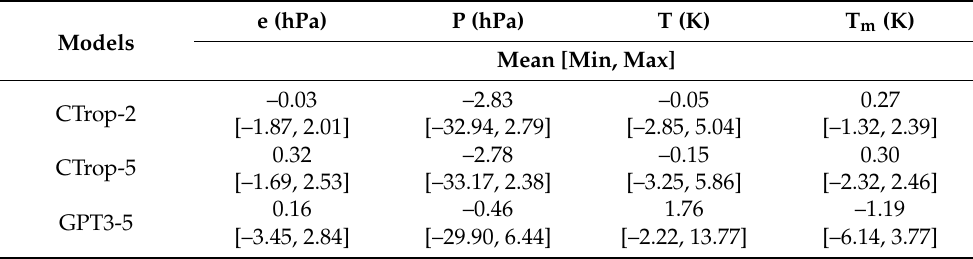
Table 3. Statistics of the bias of different resolutions of the CTrop model compared with the GPT3-5